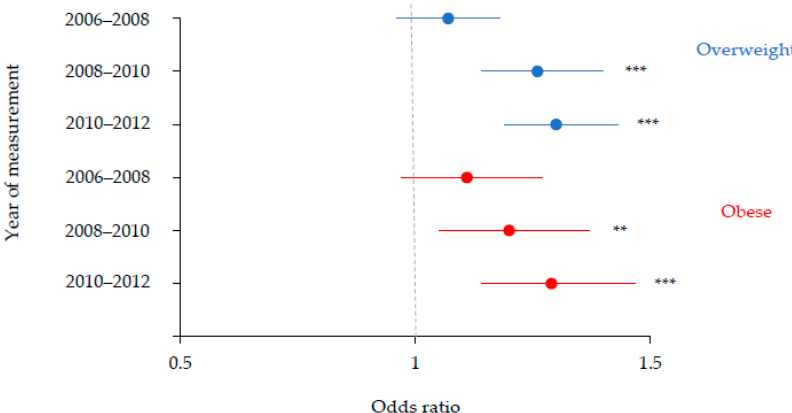
Figure 2. Odds ratios with 95% confidence intervals illustrating associations between deprivation and weight status among Reception aged Liverpool children between 2006 and 2012. The highest decile of deprivation was the reference category. Adjusted for gender. ** p < 0.01; *** p < 0.001.